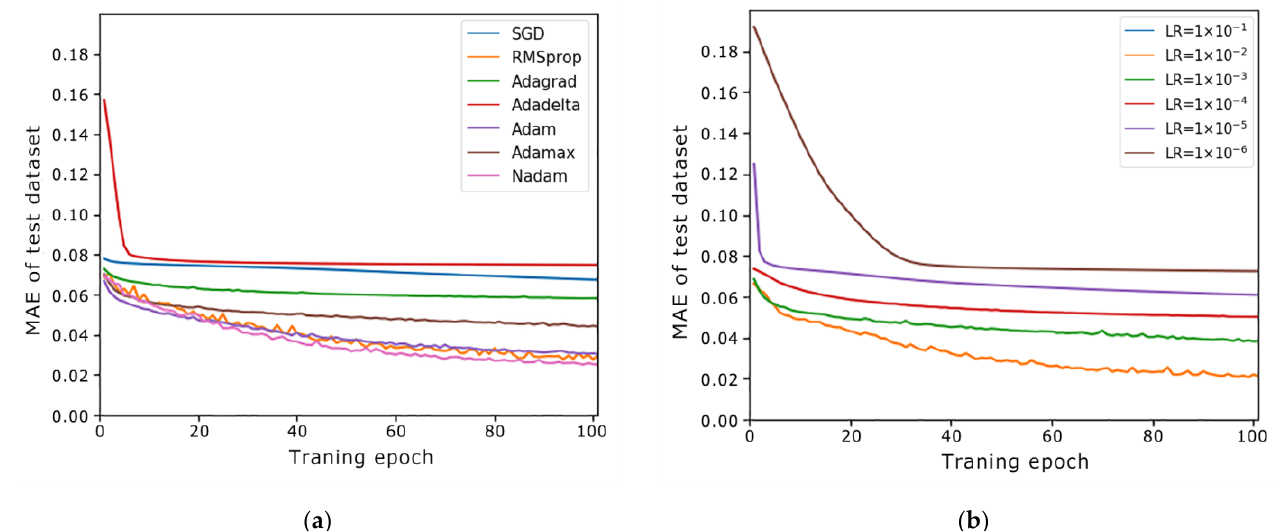
Figure 7. Mean absolute error (MAE) of the test dataset on 100 training epochs for different opti- mizers and learning rates in 2D-CNN model. ( a ) MAE obtained with the seven optimizers ; ( b ) MAE obtained with the learning rates of the optimizer of Nadam.